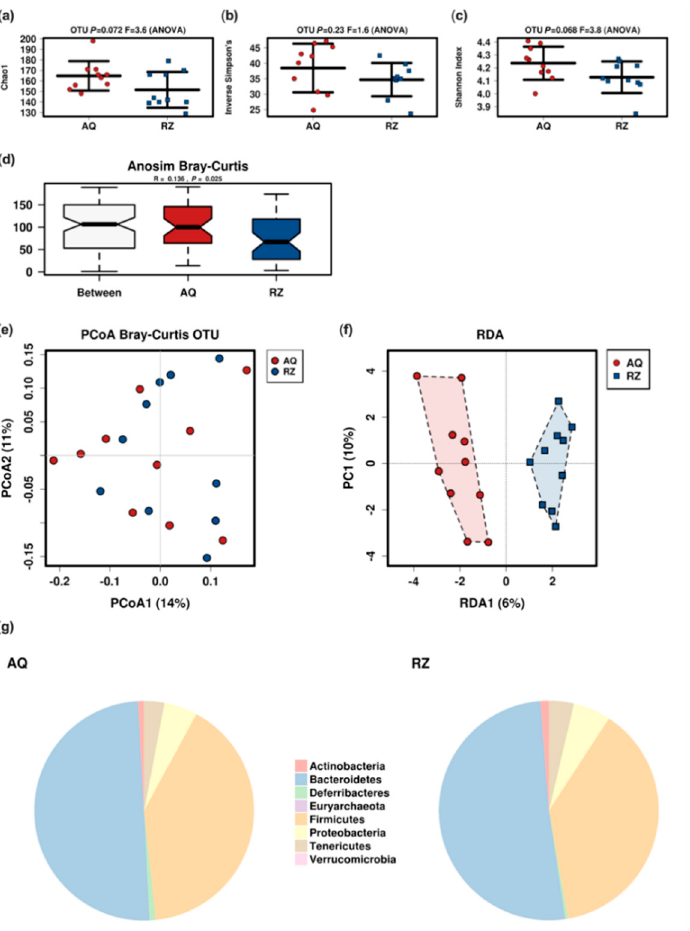
Figure 2. Microbiome analysis of the two groups. Alpha ( a – c ) and beta-diversity;( d – f ) indices (RDA: variance 23.12; F 1.17; p 0.07); pie charts of the mean relative abundance at the phylum level ( g ). AQ…aqua control group; RZ…(S)-reutericyclin group.